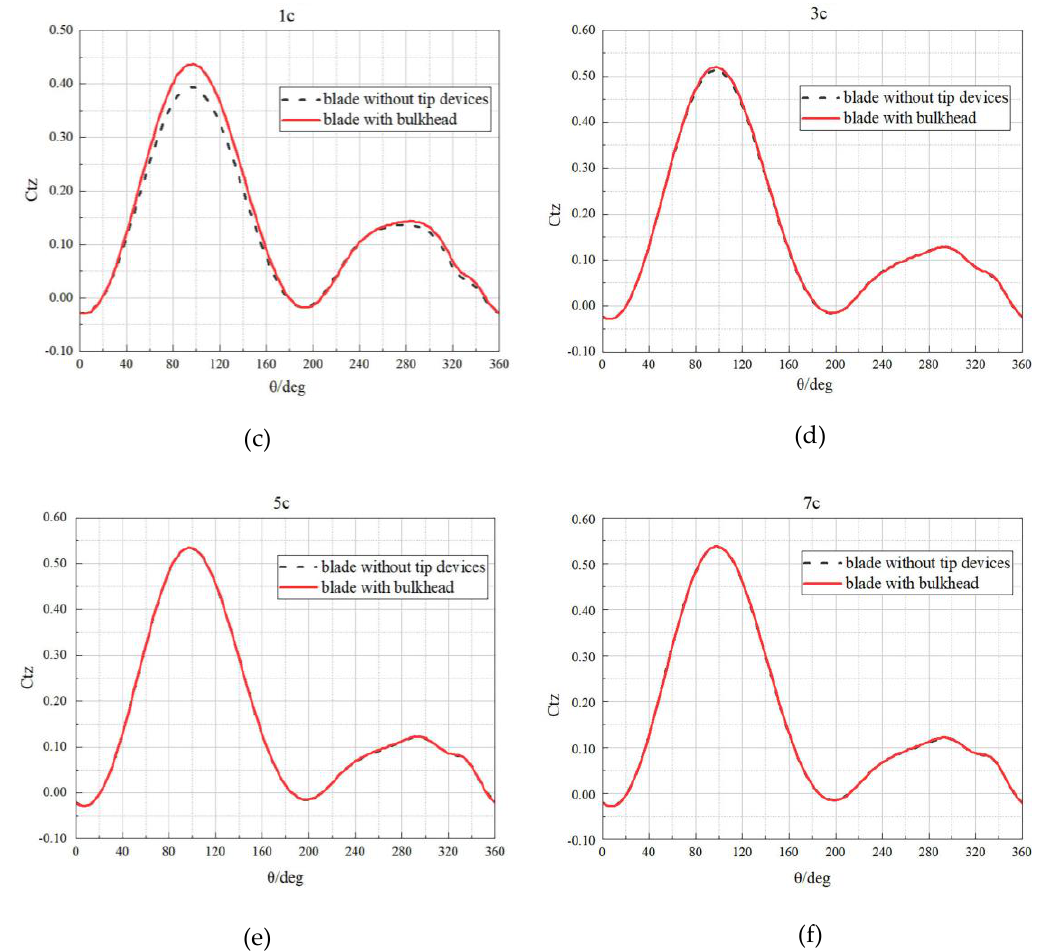
Figure 16. Instantaneous torque with or without a bulkhead at height of ( a ) 0.25c; ( b ) 0.5c; ( c ) 1c; ( d ) 3c; ( e ) 5c; ( f ) 7c.